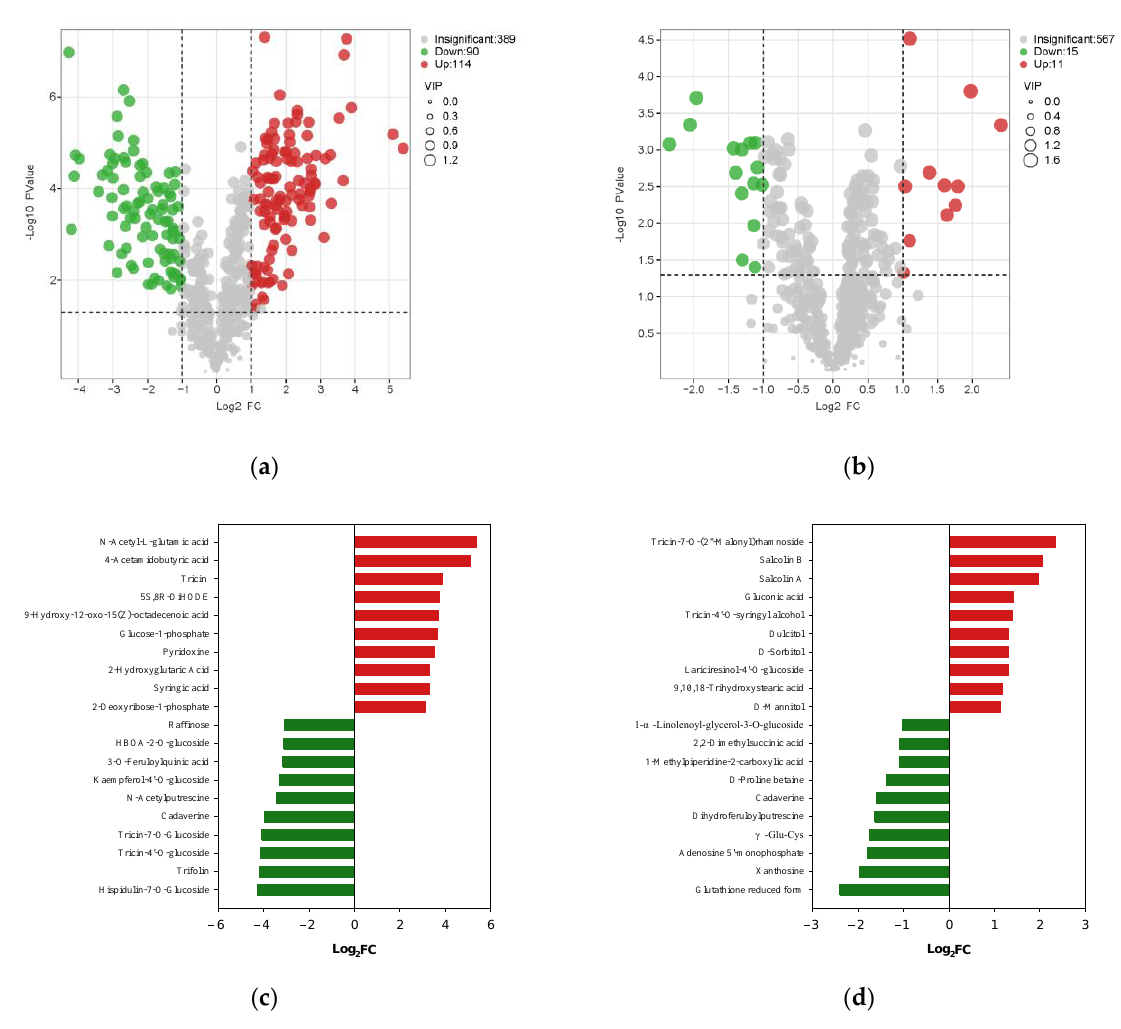
Figure 4. The metabolic variation between stored rice compared with fresh rice. ( a ) Volcano plot of the different metabolites in NJS vs. NJF group. ( b ) Volcano plot of the different metabolites in JZS vs. JZF group. ( c ) Up-regulation/down-regulation of the top 10 differential metabolites in NJS vs. NJF group. ( d ) Up-regulation/down-regulation of the top 10 differential metabolites in the JZS vs. JZF group. Table 2. Common differential metabolites of two varieties.